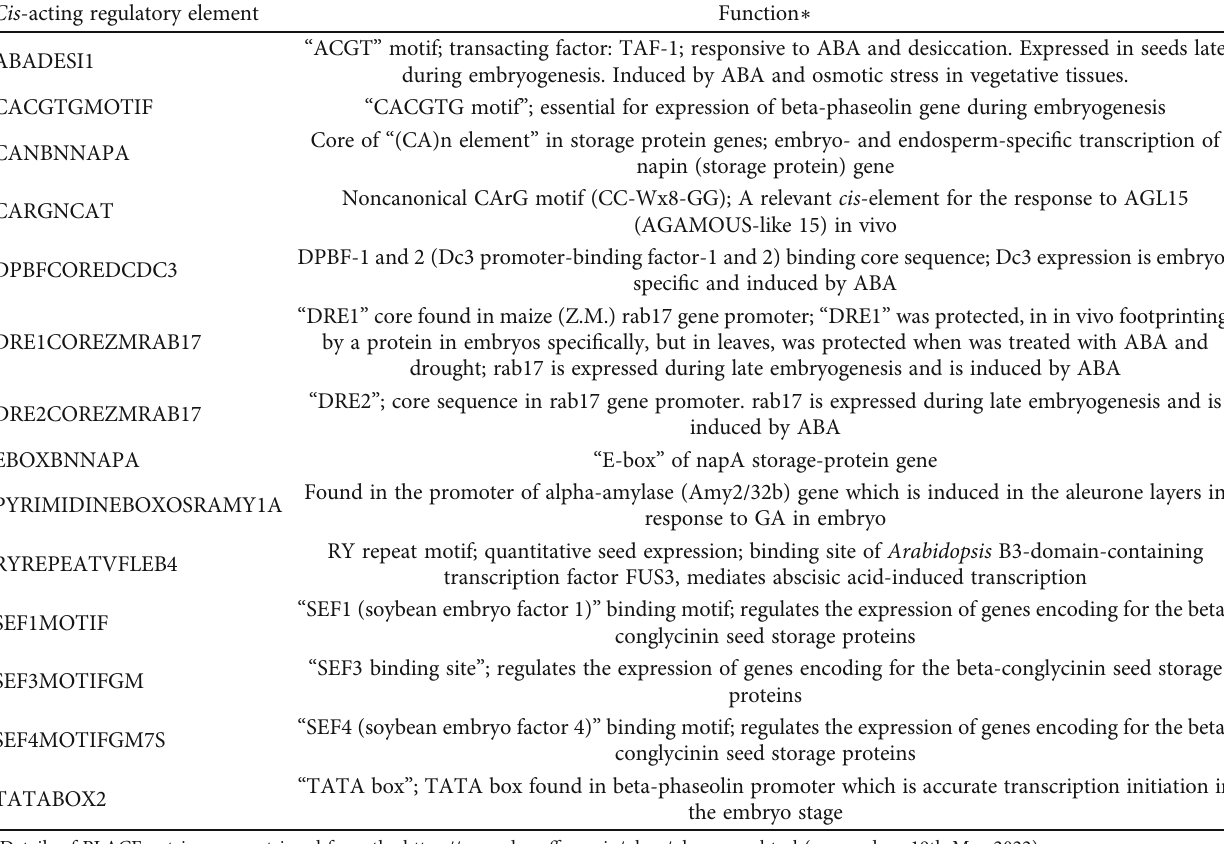
Table 3: Functional roles of several important CREs detected in the functionally uncharacterized hub gene promoter sequences retrieved from the PLACE database [46]. Cis -acting regulatory element Function ∗ “ ACGT ” motif; transacting factor: TAF-1; responsive to ABA and desiccation. Expressed in seeds late ABADESI1 during embryogenesis. Induced by ABA and osmotic stress in vegetative tissues. CACGTGMOTIF “ CACGTG motif ” ; essential for expression of beta-phaseolin gene during embryogenesis